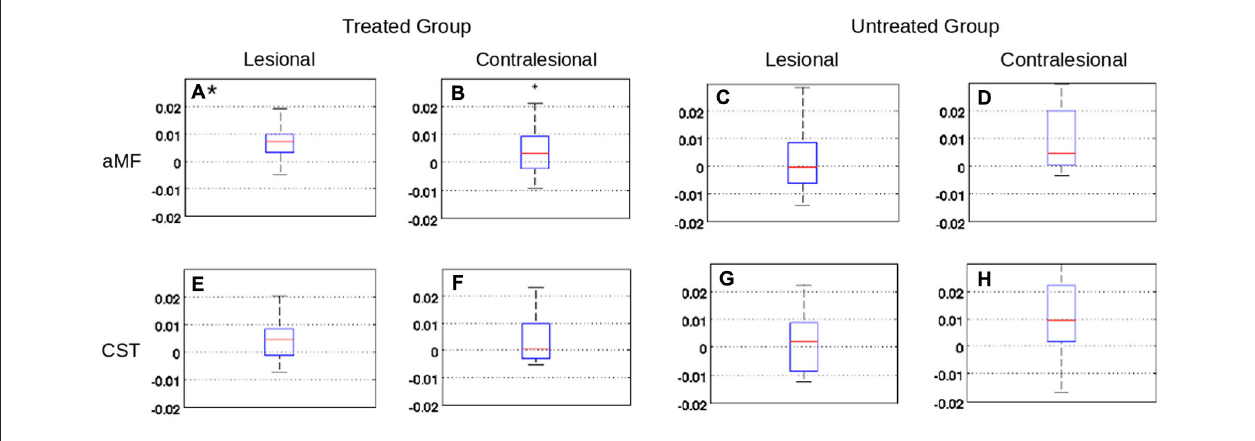
showed a significant ( p ≤ 0.01, Bonferroni corrected) increase in FA (see panel A* ). Remaining regional values in the treated group (B,E,F) or regional values in the untreated group (C,D,G,H) did not show significant changes.